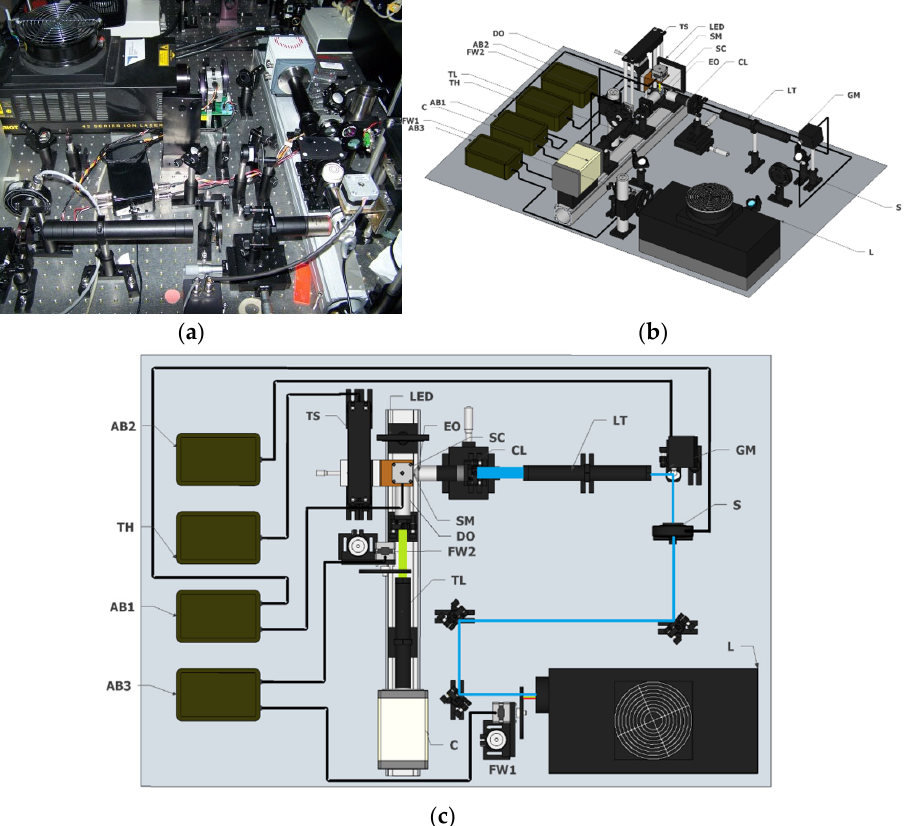
Figure 1. Open Spin Microscopy set up. ( a ) Picture of the set up. ( b ) Schematic drawing of the set up. ( c ) Top view of the set up. The different elements are: (L) Laser; (FW) Filter Wheel; (S) Shutter; (GM) Galvo Mirror; (LT) Telescope System; (TL) Tube Lens; (C) Camera; (AB) Arduino Board; (EO) Excitation Objective; (DO) Detection Objective; (SM) Stepper Motor; (SC) Sample Cuvette (TS) Thorlabs Stage; (TH) Thorlabs Stage Controller; (CL) Cylindrical Lens. For detection, air objectives (Nikon Plan Fluor 4×; NA: 0.13; WD: 17.4 mm or Plan Fluor 10×; NA: 0.3; WD: 16.7 mm) or a water immersion objective (Nikon LWD 16×; NA: 0.8 WD: 3 mm), placed perpendicularly to the excitation plane, are used to collect fluores ‐ cence emission. Excitation light is rejected using emission filters placed in the infinity